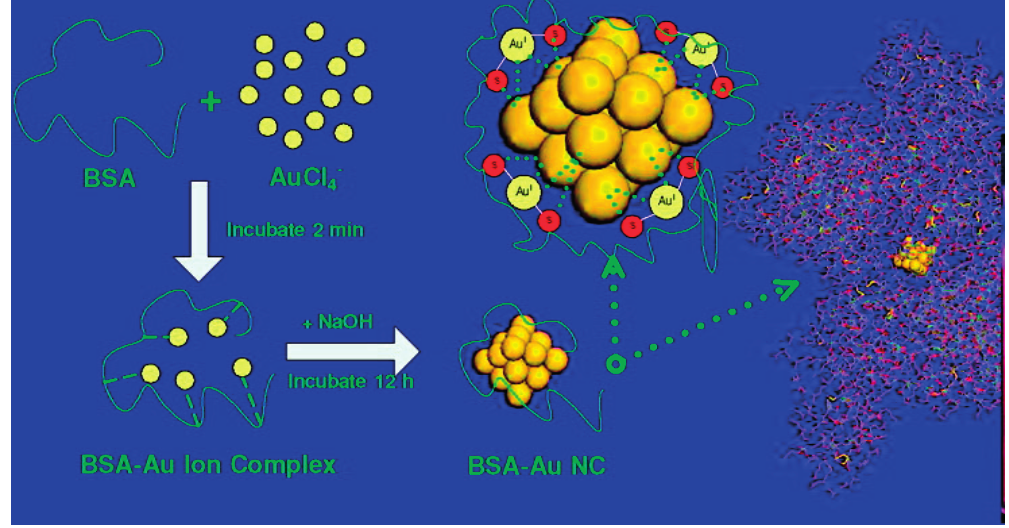
Figure 5. Formation of BSA-AuNCs [132]. Reprinted with permission from [132]. Copyright (2014) American Chemical